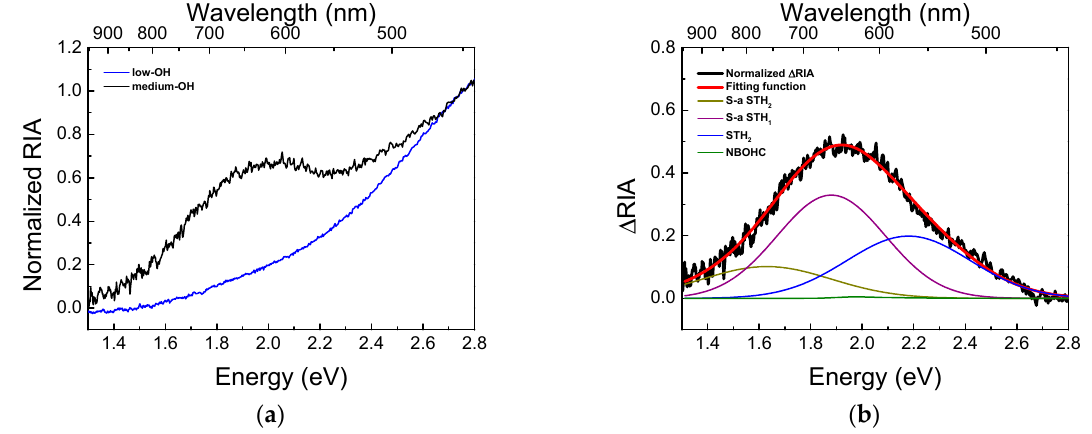
Figure 8. ( a ) Normalized spectra with respect to the RIA measured at 2.8 eV (450 nm) for the low - and medium -OH samples at 10 kGy dose. ( b ) Fitting function obtained for the difference of the normalized RIA of the medium - and low -OH samples measured at a dose of 10 kGy.